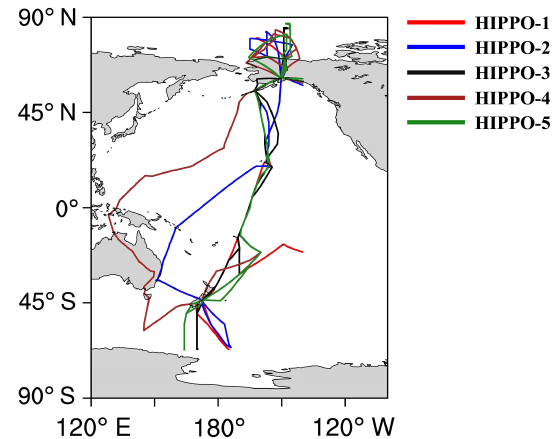
Figure 3. Flight track of the five HIPPO missions. Colored lines in red, blue, black, brown and green represent flight track of HIPPO-1 to HIPPO-5, respectively. Flights over continental North America east of 140 ◦ W were not included in this